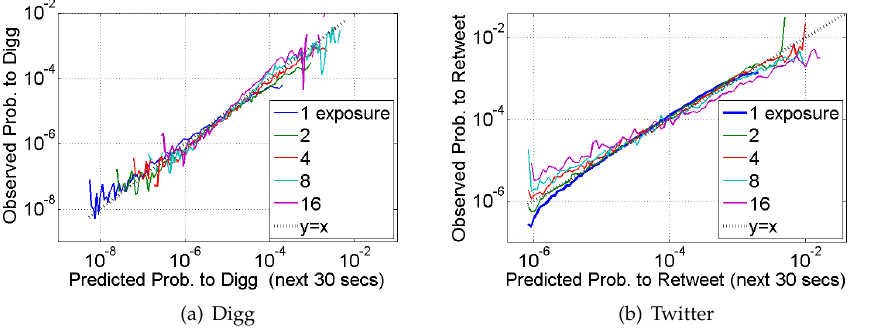
Figure 8. Predicting response. Observed probability to ( a ) digg or ( b ) retweet an item as a function of predicted probability, for different numbers of exposures to the